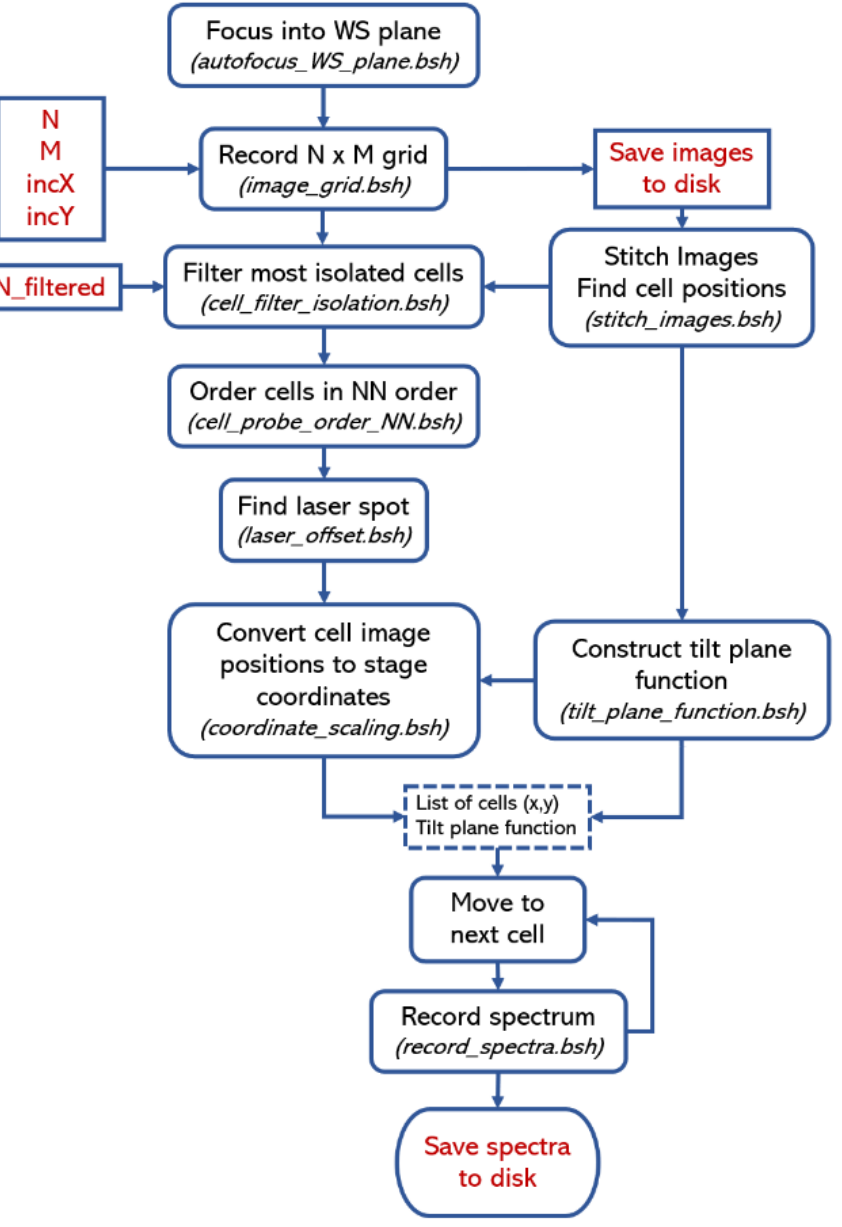
Figure A1. Flow chart of automated Raman spectroscopy routine. Flow chart detailing full list of processes to automate cell detection and probing. Manually set global variable inputs, and resultant output data highlighted in